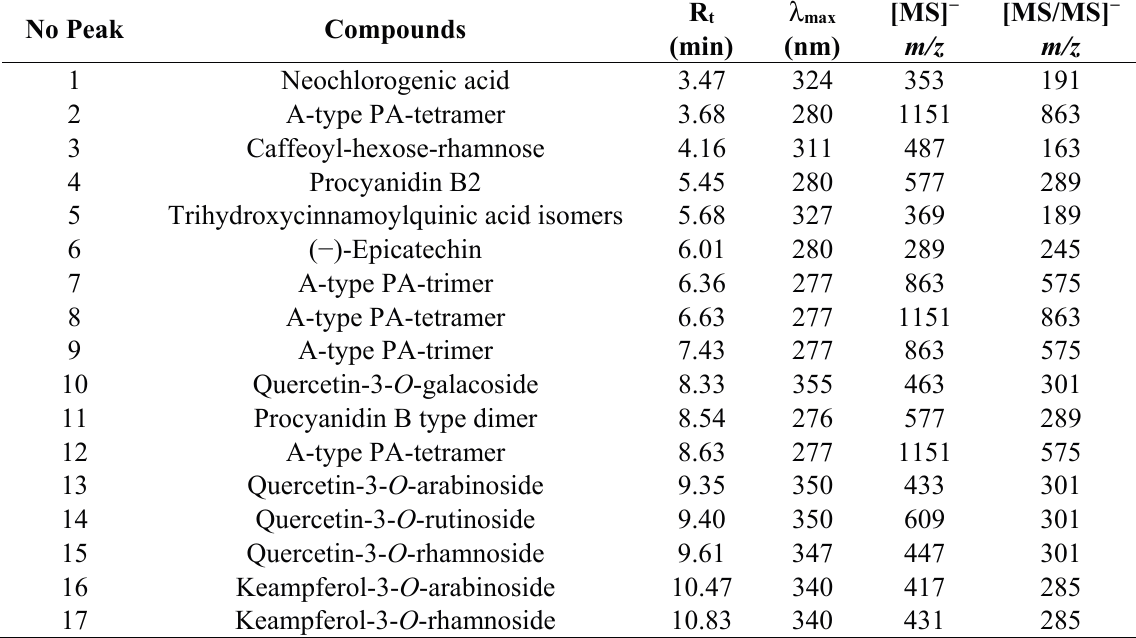
Table 1. Identification of phenolic compounds in white and red chestnut horse leaves using their spectral characteristic with UPLC-PDA (retention time, λ max ) and negative ions with LC-ESI-MS.